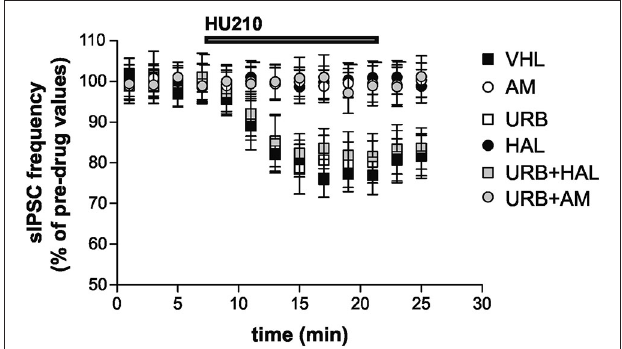
FIGURE 4 | Electrophysiological effects. Stimulation of CB 1 receptors with HU210 caused inhibition of striatal GABAergic sIPSCs in the VHL group. AM251 (alone or with URB597) and haloperidol treatments resulted in the suppression of HU210 effects. CB 1 receptor sensitivity was rescued when haloperidol and URB597 were coadministered, although URB597 alone did not increase HU210